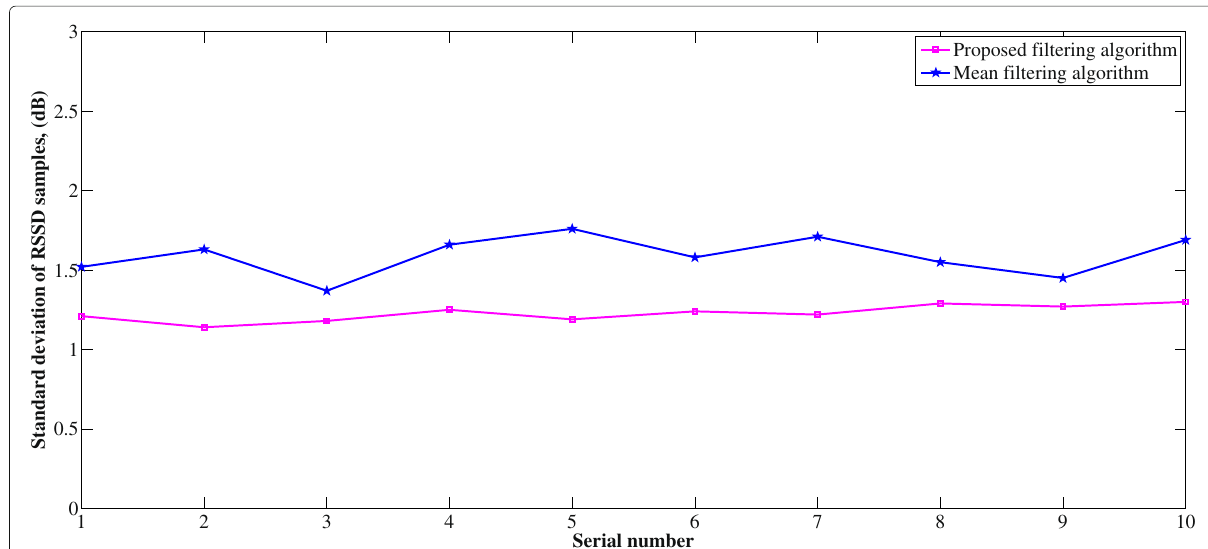
Fig. 7 RSSD sample standard deviation comparisons. P ( d 0 ) = 10 dB, α = 1.8, σ = 5.2 dB, d = 2 m, t = 50, positioning area (100 m × 100 m), and 4 APs ( ( 17,25 ) m, ( 43,75 ) m, ( 67,75 ) m, ( 83,25 )